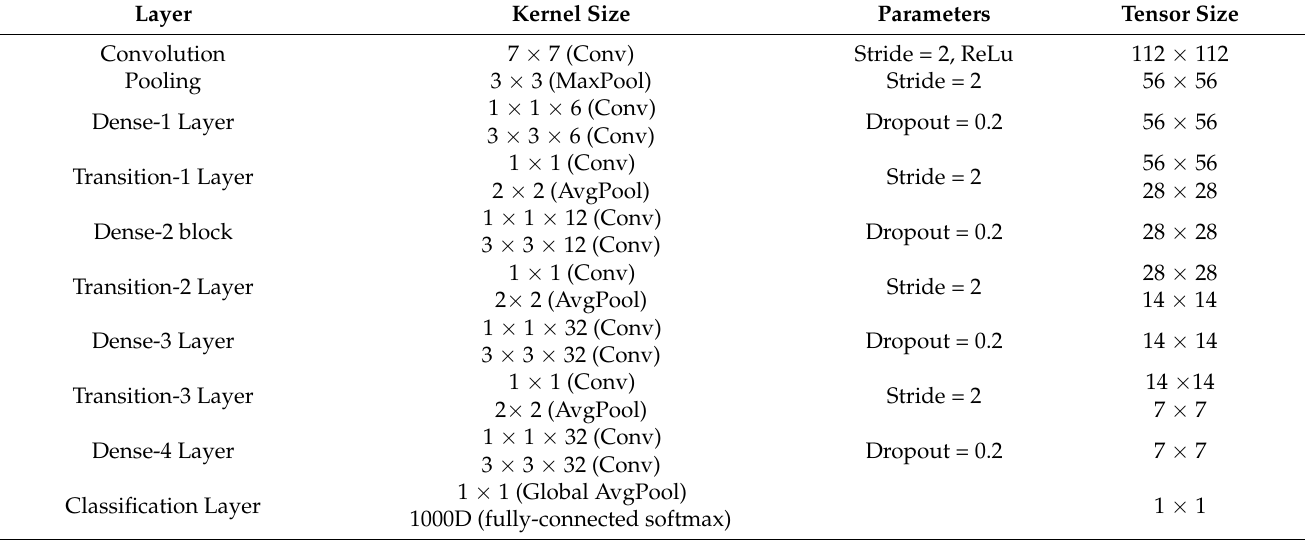
Table 3. DenseNet-169 layered